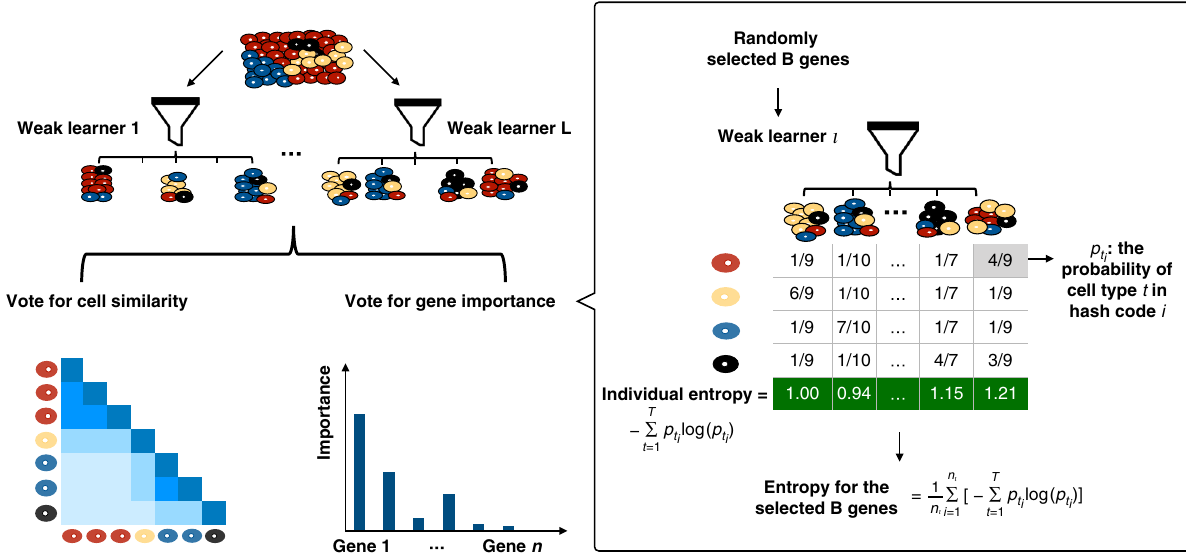
Fig. 1 Overview of EDGE. The algorithm starts by generating a number of weak learners. Each weak learner consists of a few hash codes (imaginary boxes, i.e., piles of cells). For cells assigned to the same hash code, their pairwise similarity scores are set to be 1s and 0s otherwise. Each weak learner is a voter. The fi nal similarity probabilities between cells are calculated by averaging the corresponding similarity scores from each voter. The calculated probabilities are used in embedding estimation and optimization. The important scores of genes in each weak learner are obtained by averaging the hash codes' entropy values. Details of the algorithm can be found in Methods and Supplementary